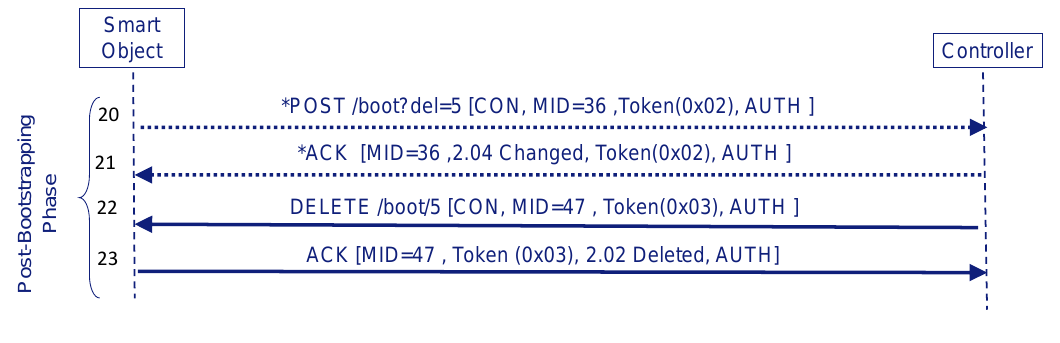
Figure 7. Example of deleting bootstrapping state (with AUTH-based